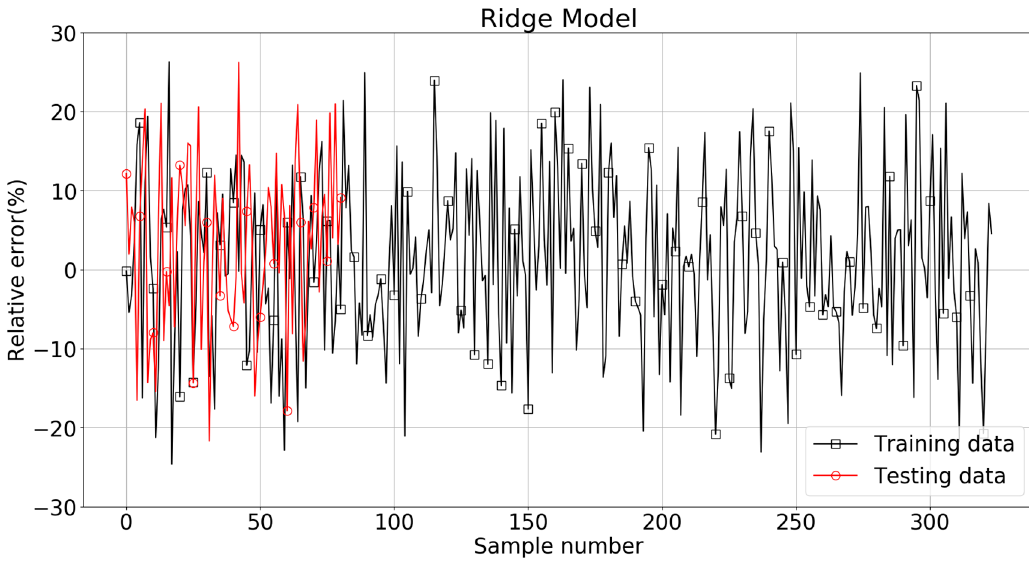
Figure 10. Variation of the relative errors obtained from the Ridge model.